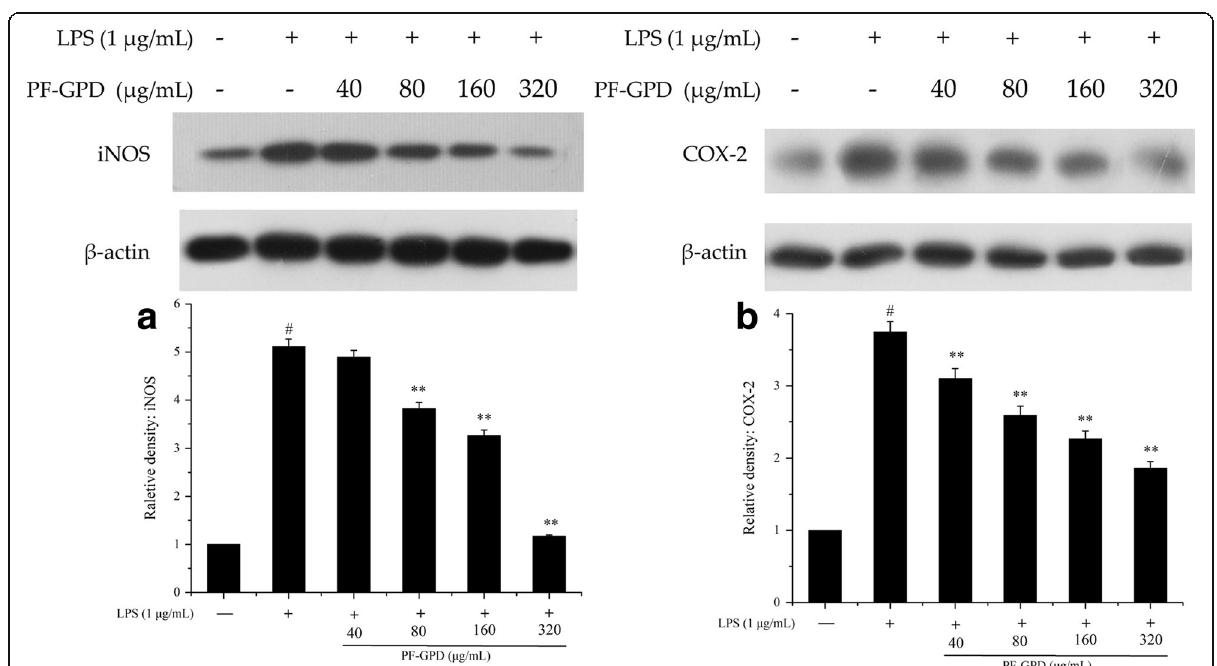
Fig. 5 Effect of PF-GPD on LPS-stimulated iNOS ( a ) and COX-2 ( b ) mRNA in RAW 264.7 cells. Cells pretreated with indicated concentrations of PF-GPD or dexamethasone (0.5 μ g/mL) or indomethacin (2.5 μ g/mL) for 6 h were stimulated without or with 1 μ g/mL of LPS for 18 h. The mRNA of iNOS, COX-2 and GAPDH were detected by real time PCR using corresponding primers. ## P < 0.01 compared with untreated group; * P < 0.05, ** P < 0.01 compared with the LPS group